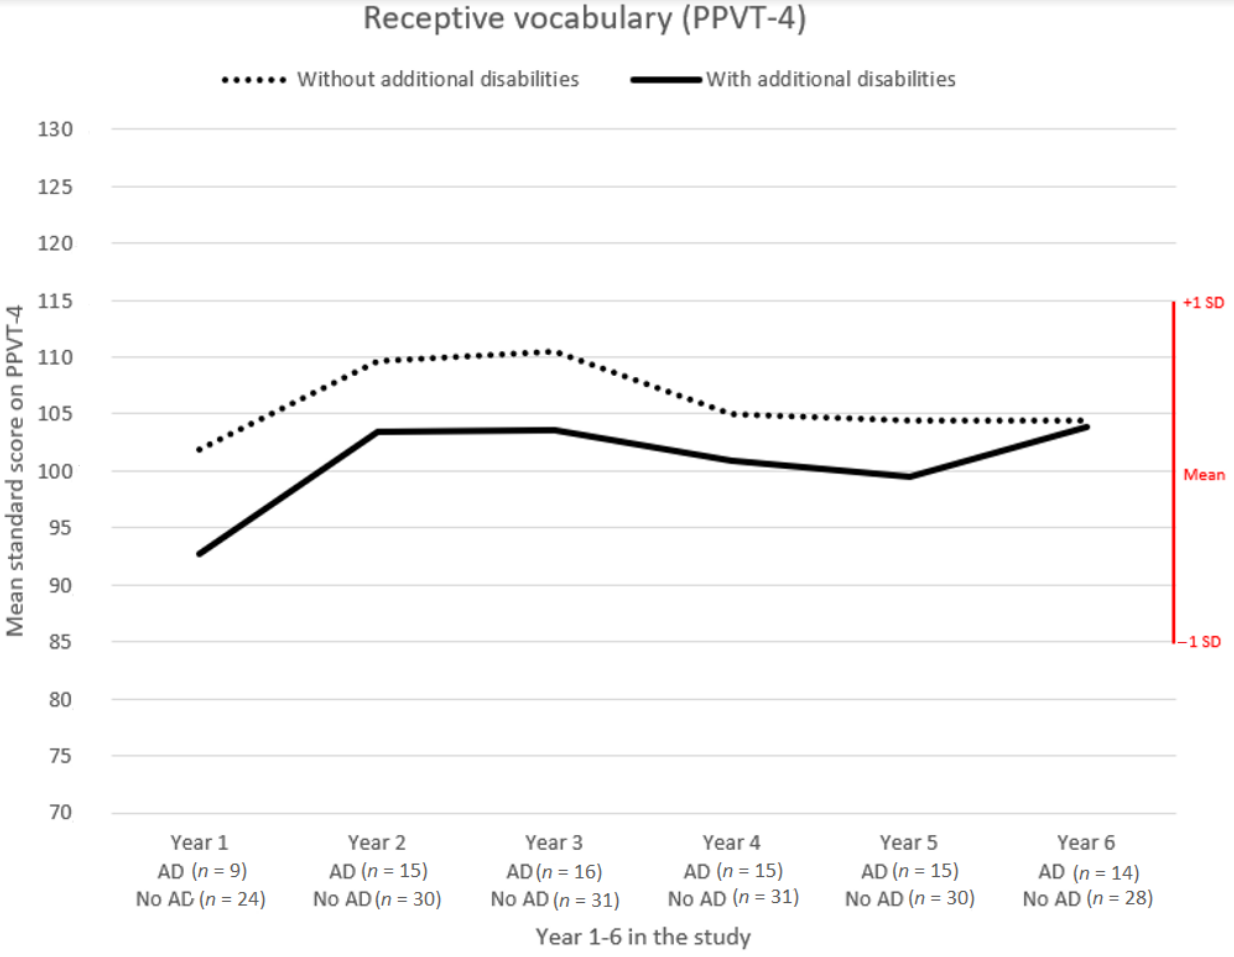
Figure 3. Comparison of mean standard scores on PPVT-4 of children with and without additional disabilities (AD), over the 6-year project period.